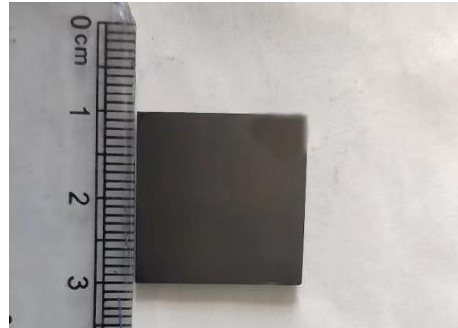
Figure 1. The external dimensions of the sample.